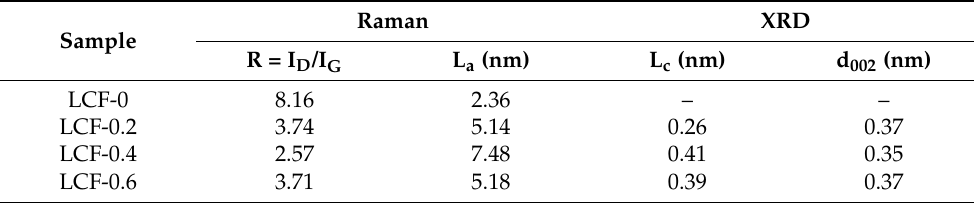
Table 2. Calculated Raman spectroscopy and XRD results for the LCFs.